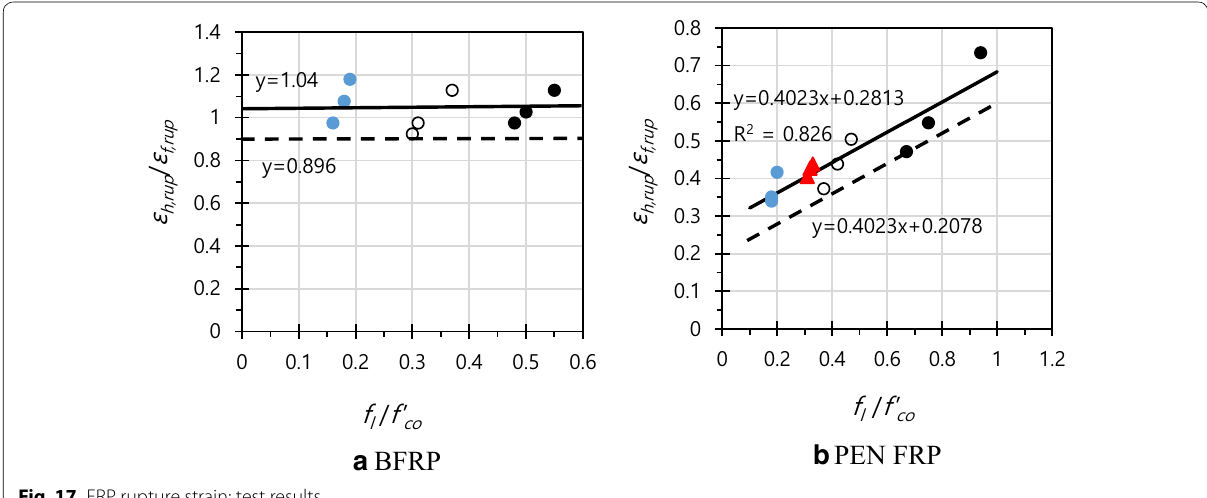
Fig. 17 FRP rupture strain: test